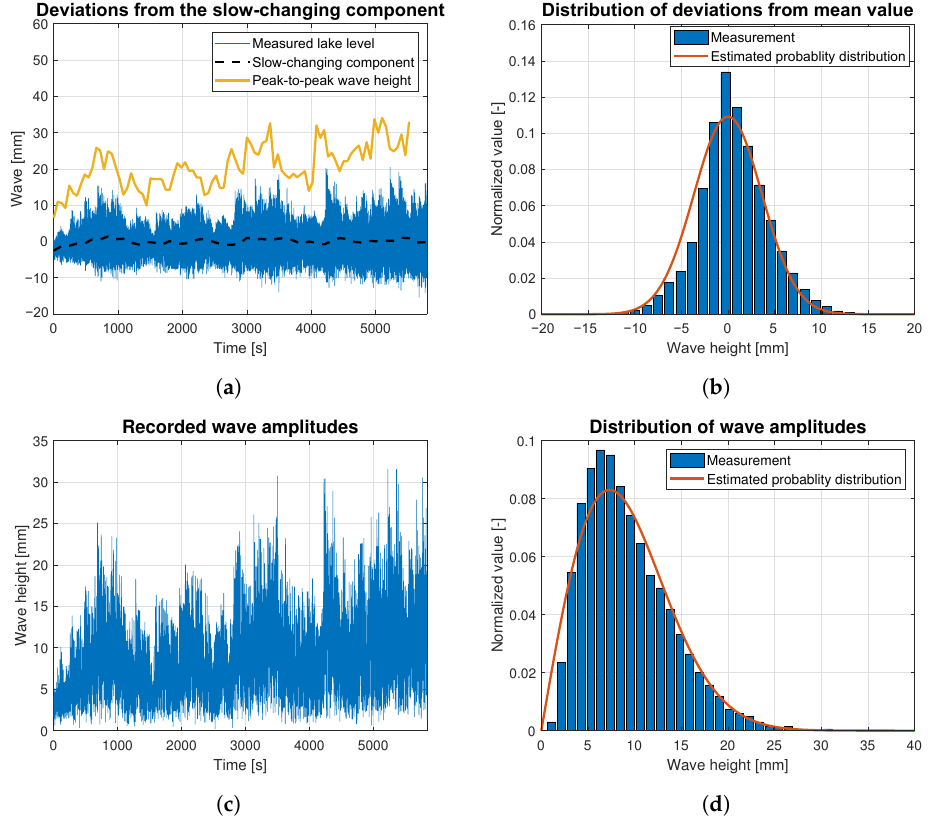
Figure 11. Statistical analysis of the wave height corresponding to 5 BFT wind force in ship scale: ( a ) deviations from the slow-changing component; ( b ) probability distribution of wave height deviations from mean value; ( c ) recorded wave amplitudes; ( d ) probability distribution of wave height